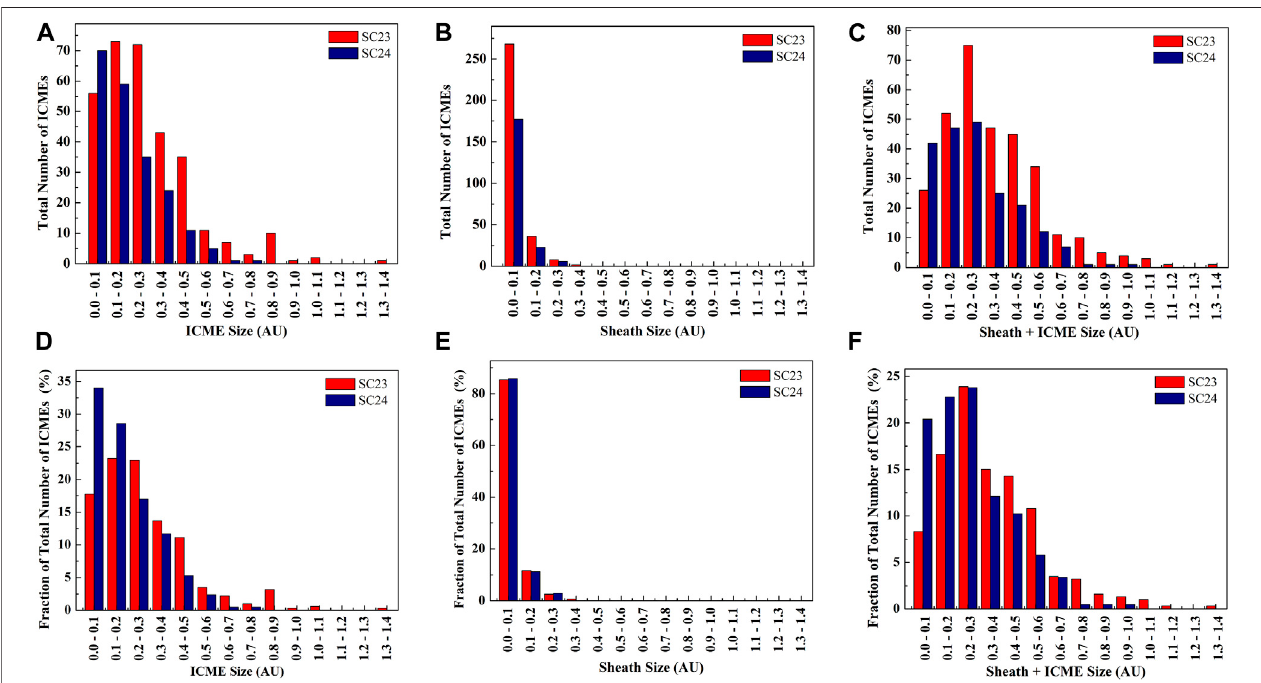
FIGURE 2| The distributions ofthe radial sizes of ICMEs region, sheaths region precedingICMEs,and the entire region ofICMEs together with sheaths (i.e., entire transients) for solar cycles 23 and 24 are shown. (A),(B),(C) and (D),(E),(F) show the distributions for the total number of ICMEs and the percentage fraction of the total number of ICMEs in each bin of duration,